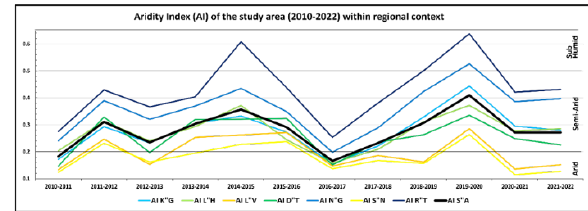
Figure 2. AI of the study region between 2010-2022 (Sources: I.M.S., 2023; SOLPOS, 2023). The seven stations are Kiryat Gat (K”G), Kibbutz Halamed’Hay (L”H), Lehavim (L”V), Dorot (D”T), Negba (N”G), Shani (S”N) and Rosh Tzurim (R”T). The Study Area (S”A) is depicted in thick black line.